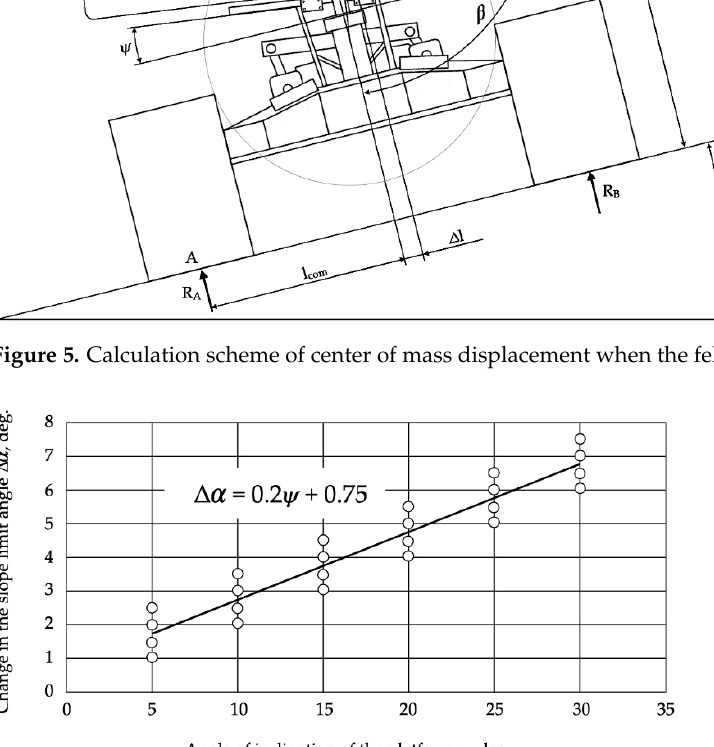
Figure 6. Diagram of change in the slope of the terrain from the angle of inclination of the platform.